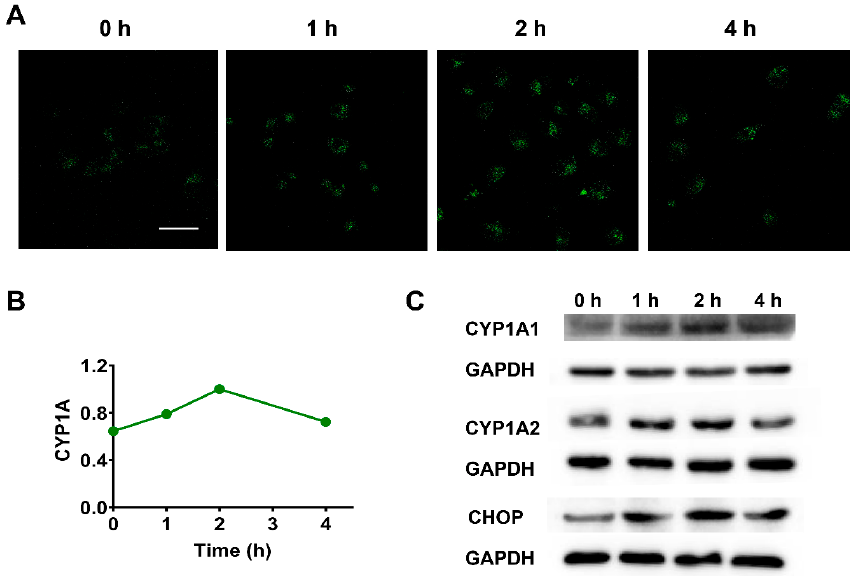
Figure 5. Two-photon fluorescence images of DTT pre-treated A549 cells. ( A ) Fluorescence images of DTT (2.5 mM, 0–4 h) pre-treated A549 cells that stain with ERNM . ( B ) Graphical quantification of average fluorescence intensity of images belonging to different experimental groups. ( C ) The protein level of CYP1A and CHOP in experimental groups treated with 2.5 mM DTT for different durations. Scale bar: 50 μ m.